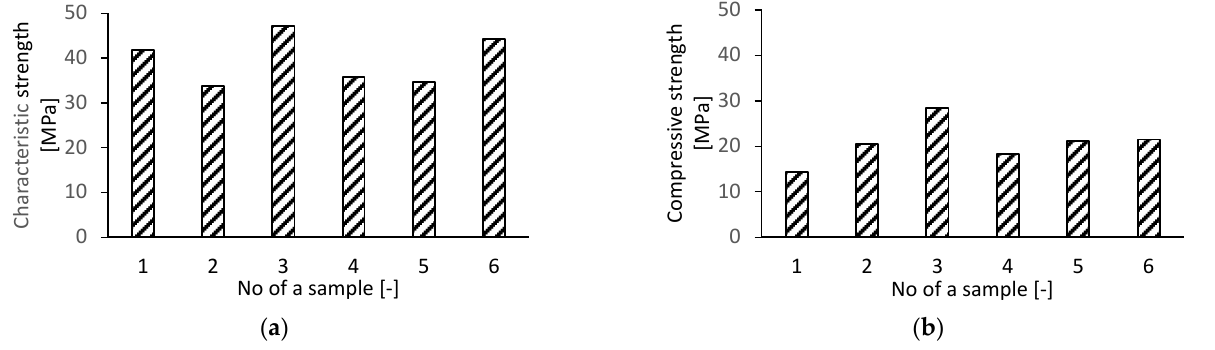
Figure 11. Results of concrete strength parameters: ( a ) on loggia wall, using Schmidt hammer, based on [80] ( b ) on external wall, using SATEC machine (based on the information provided in [79]) .